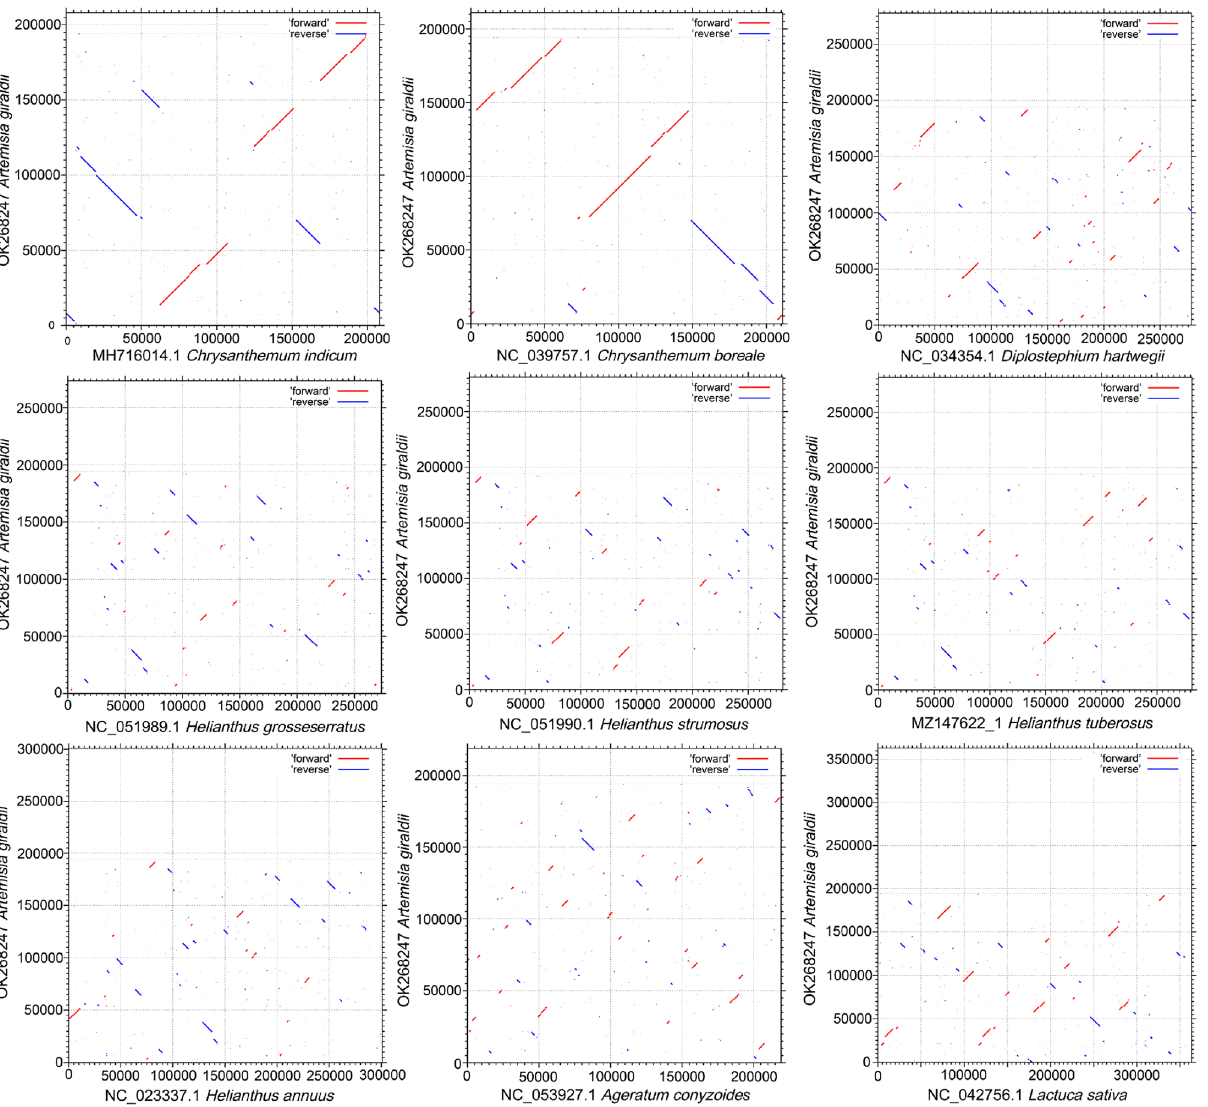
Figure 2. The dotplot graphs of collinearity between the mitogenomes of the A. giraldii and nine Asteraceae species. The vertical axis represents the A. giraldii mitogenome. The horizontal axis represents the nine Asteraceae mitogenomes, respectively. The red and blue lines showed the homologous regions in the forward and reverse direction between the A. giraldii and nine Asteraceae species, respectively. These dotplot graphs were drawn by MAFFT online service (https:// mafft. cbrc. jp/ align ment/